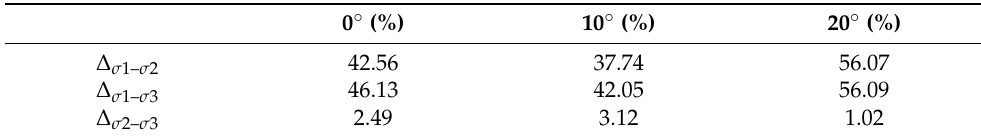
Table 10. Difference at different oblique